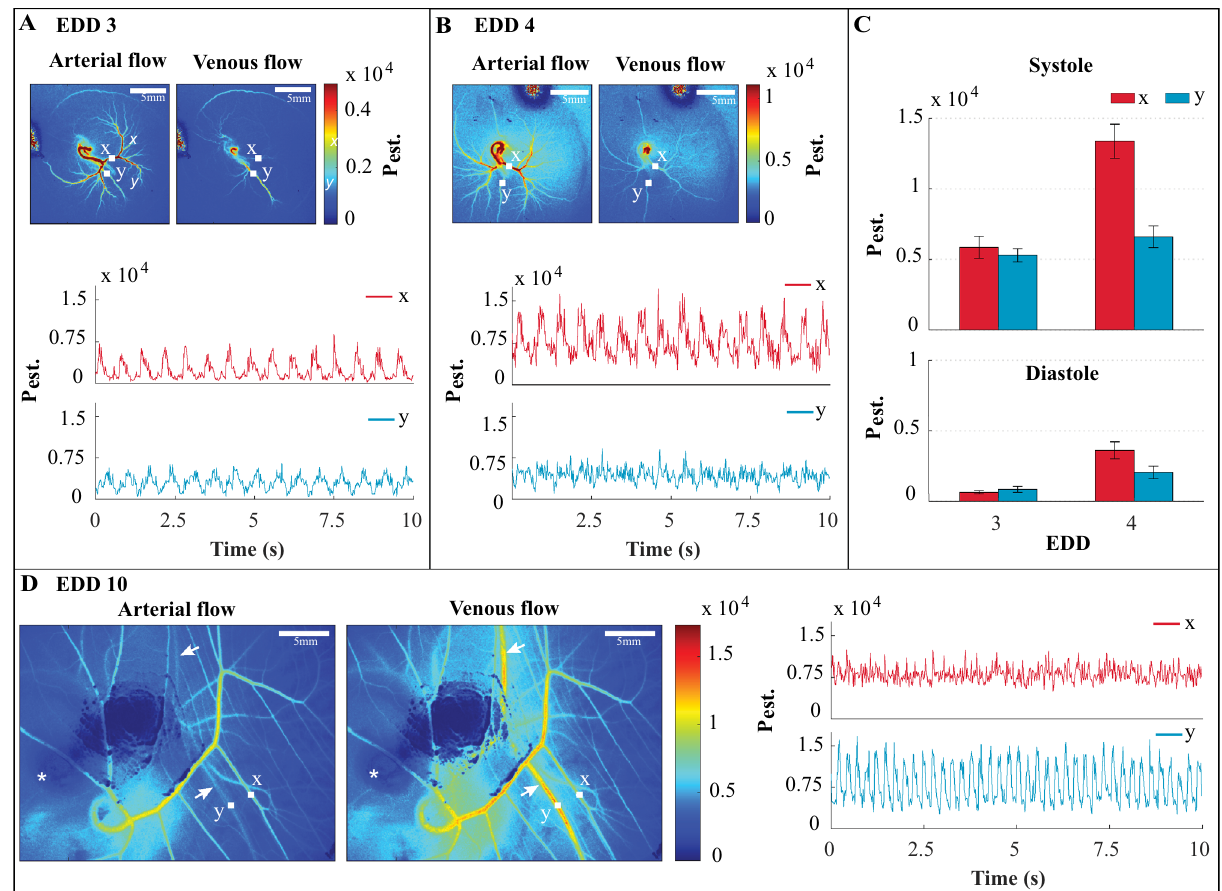
Figure 5. Blood flow distribution within arteries and veins. Panel ( A ), perfusion maps based on averaging of a number of frames chosen during systole (maximum perfusion) and diastole (minimum perfusion) from the region x that represent arterial and venous flow, respectively, for the development day 3. EDD, embryo development day. P est ., estimated perfusion. Panel ( B ) represents the same analysis as Panel ( A ) but for the development day 4. Panel ( C ), a comparison between the averaged perfusion maps (mean ± standard deviation) for both systole and diastole during days 3 and 4 of the development. x and y correspond to the regions shown in the perfusion maps of Panels ( A , B ). Panel ( D ), perfusion maps and temporal fluctuations of the perfusion extracted from the regions x and y on the development day 10. The perfusion maps labeled with arterial and venous flow are calculated by averaging of a number of frames at minimum and maximum values of the perfusion at the region y , respectively. White arrows, the vein that provides a clear signal during the venous flow. Asterisk, the eye of the embryo. The exposure time for EDDs 3–4 is 10 ms while it is 5 ms for EDD